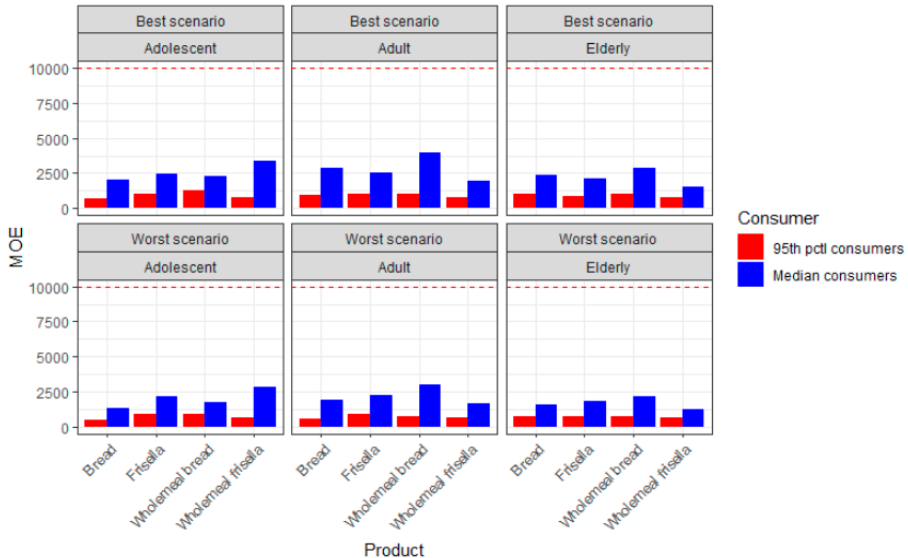
Figure 3. Margins of exposure (MOE) values for the carcinogenicity of acrylamide (AA) through the consumption of bread and products thereof, across different consumers and according to best and worst scenarios (the y-intercept at 10,000 is a threshold, as it accounts for the minimum value at which the carcinogenic MOE is considered of low concern).